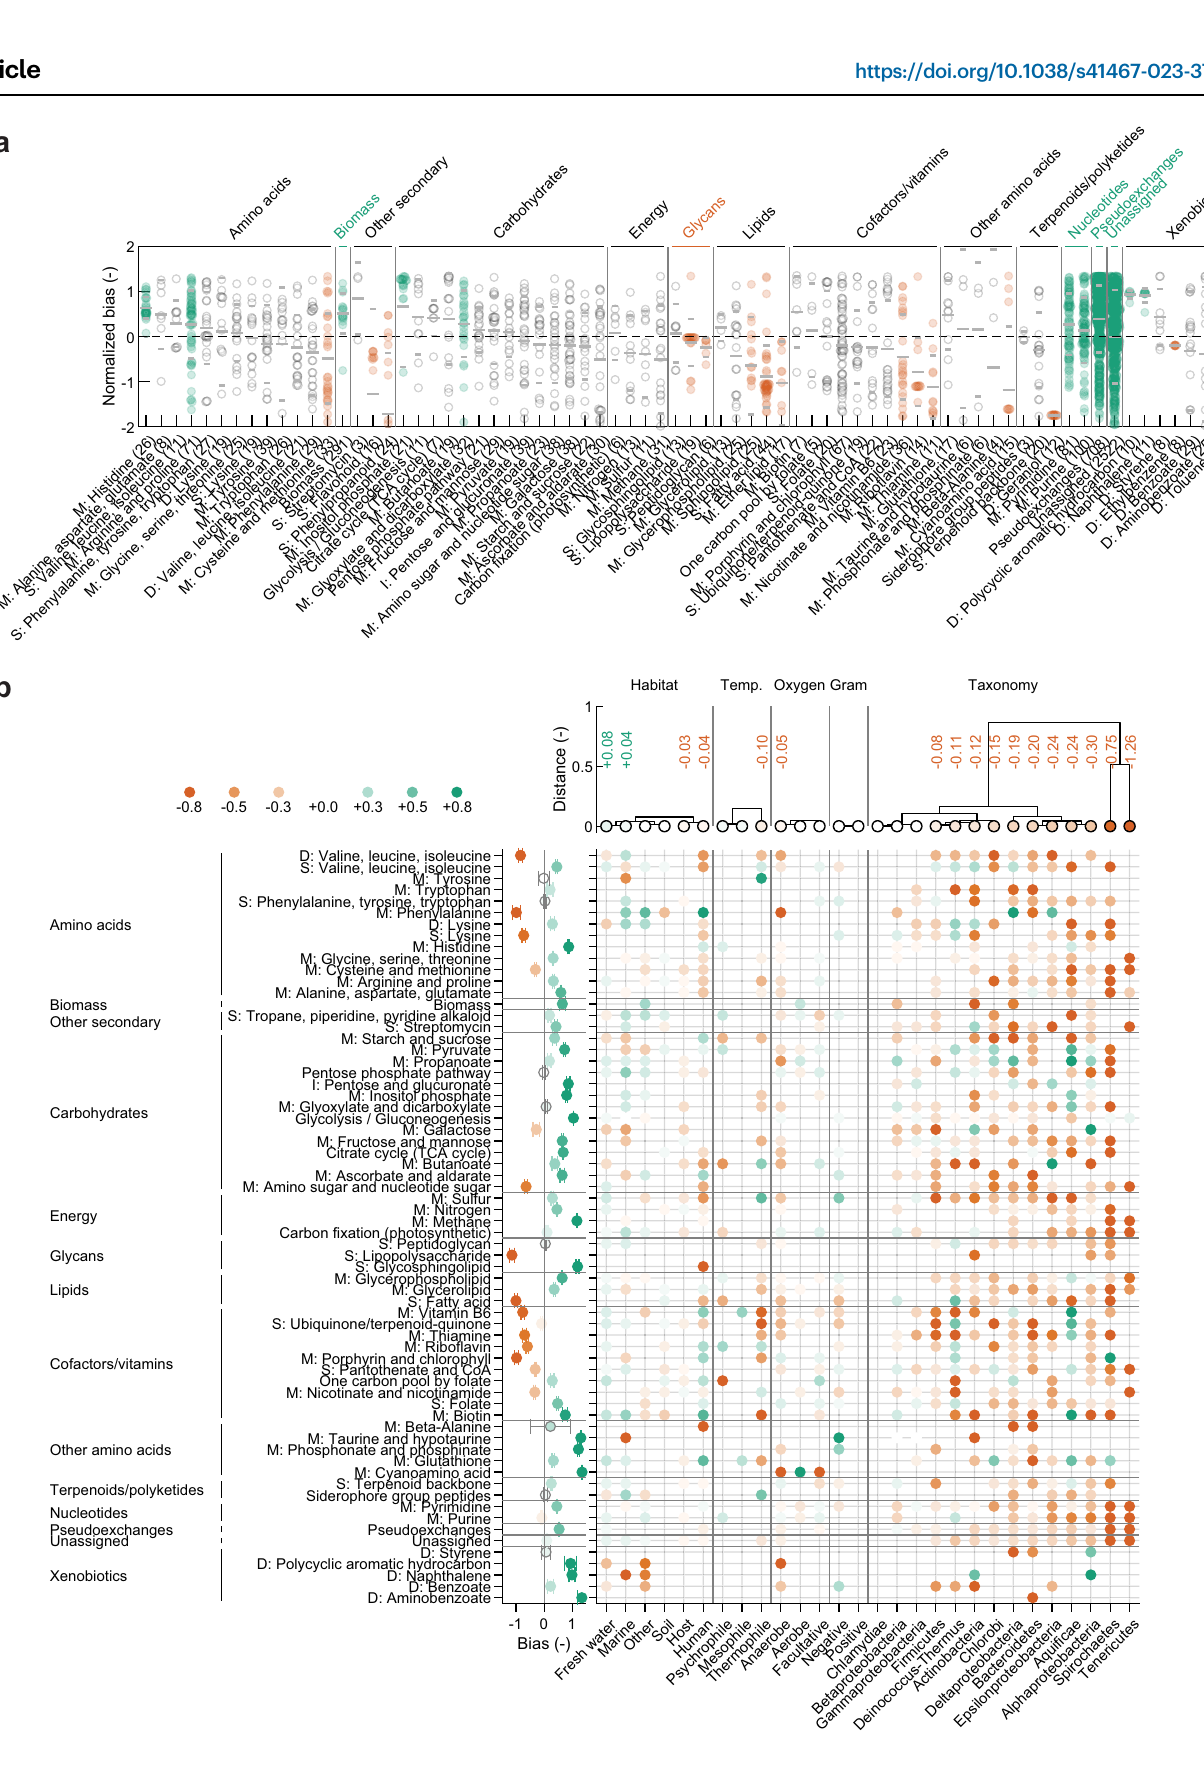
Other amino acids Terpenoids/polyketides Nucleotides Pseudoexchanges Unassigned